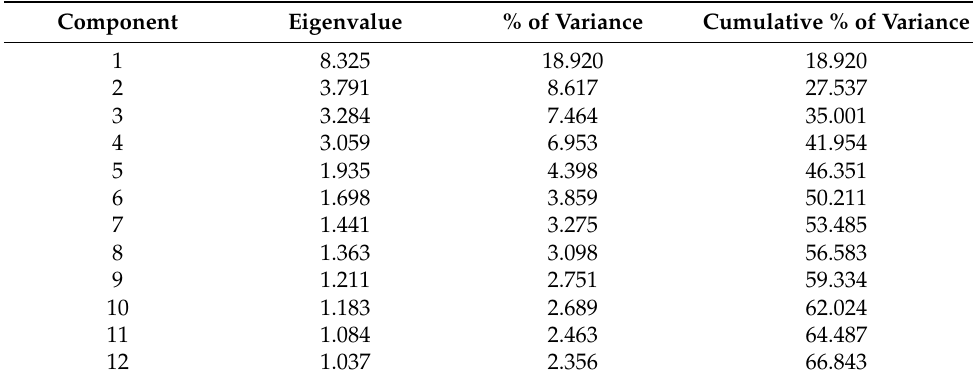
Table 3. Explained variance in the 12 extracted